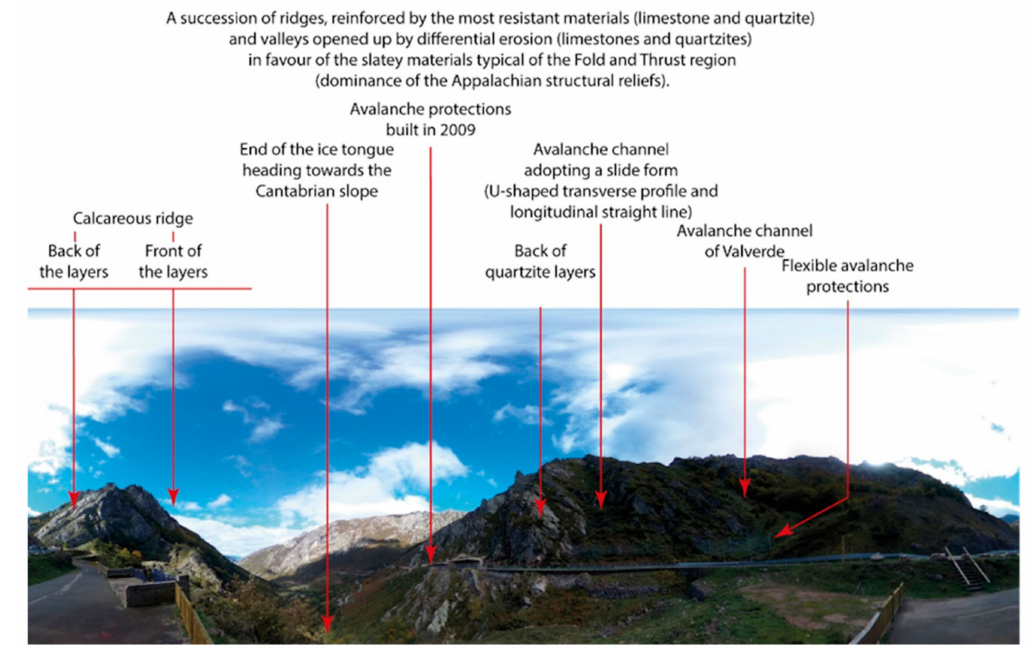
Figure 9. 360 ◦ photograph from the second POI. Photograph by the authors. Focus with camera on Figure through Onirix site or use the link [iv].